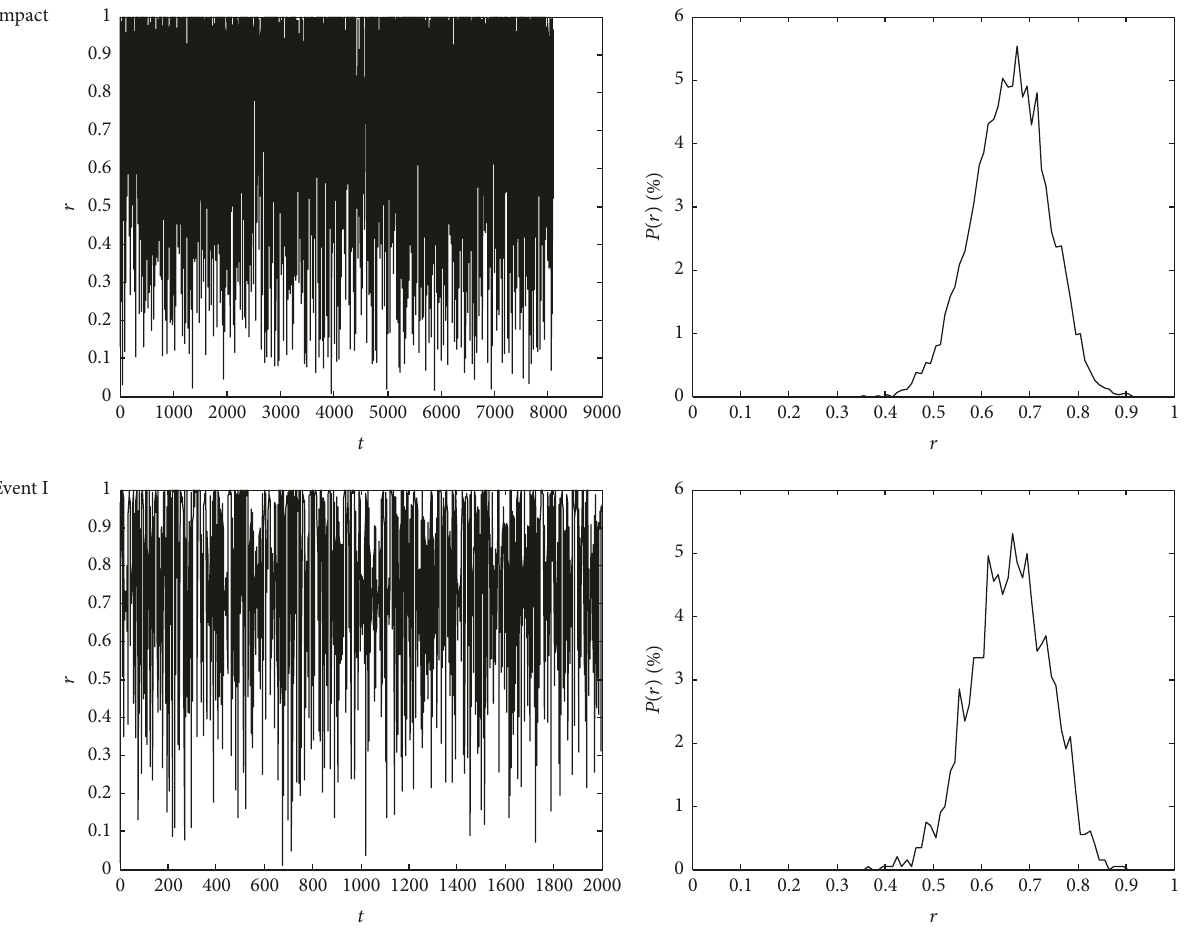
Figure 7: Variations of 𝑟 and the corresponding histogram, from the impact test, event B, and event I.